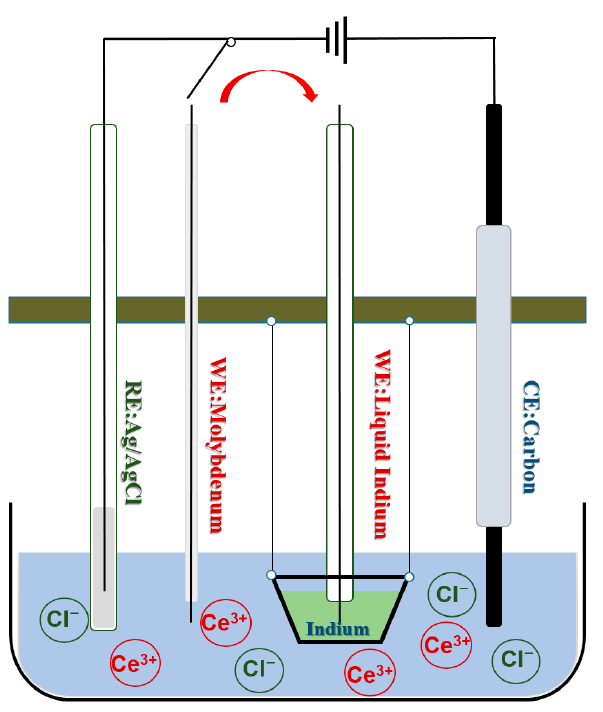
Figure 1. Schematic diagram of the equilibrium potential determination of Ce 3+ at liquid indium metal (In) electrode in the LiCl-KCl eutectic salt system.